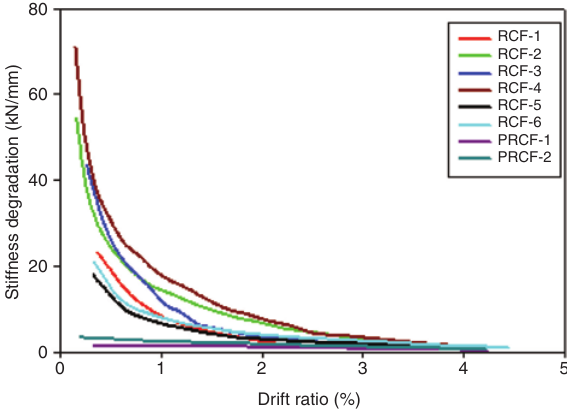
Figure 14: Stiffness degradation of the test frames.